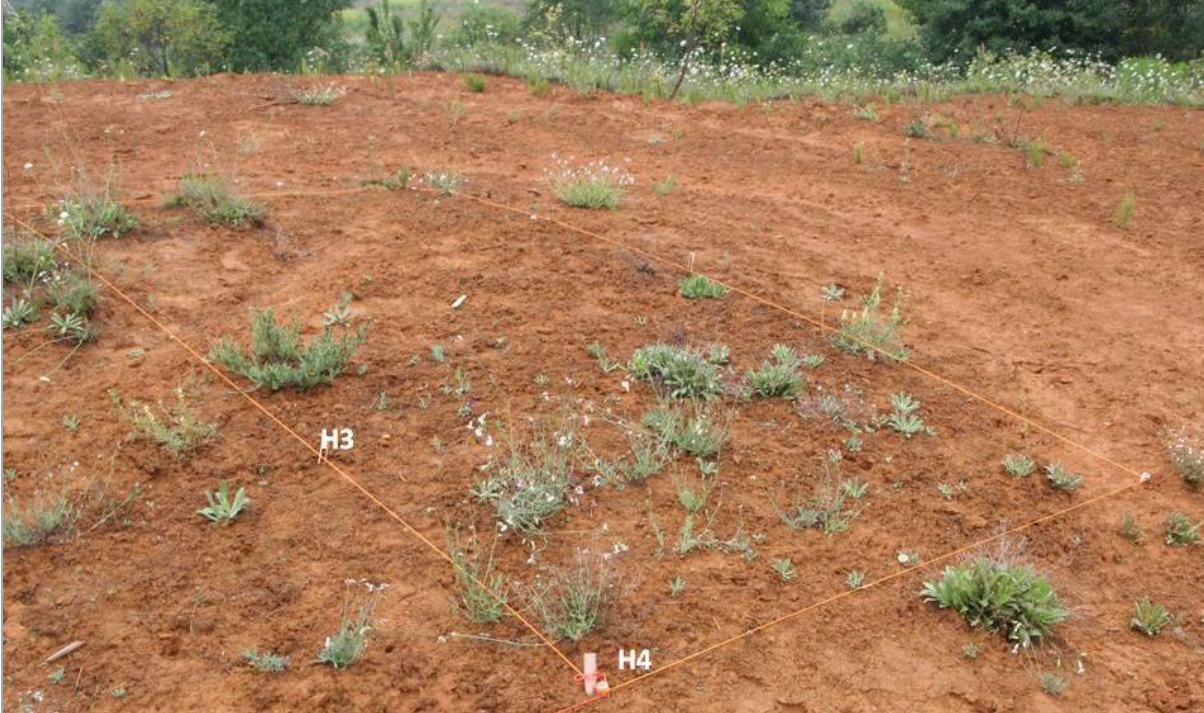
Fig. 10. Plots H3, H4 sown with seeds in 2009, in 2013 with growing Biscutella laevigata and Silene vulgaris ( A. Rostański